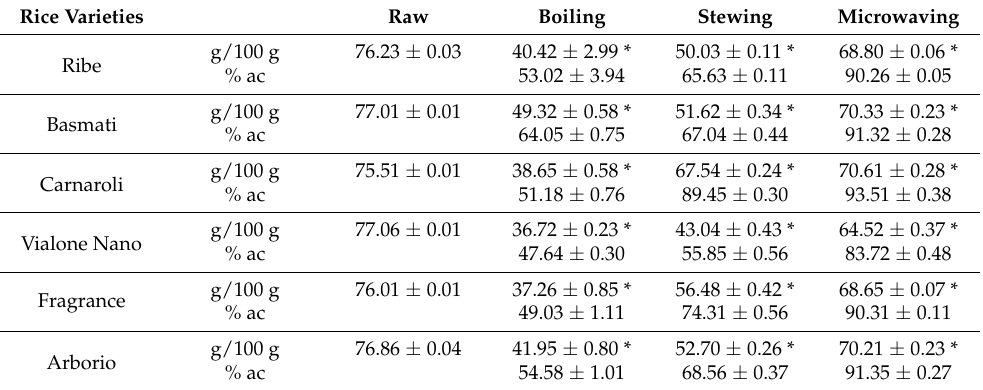
Table 4. Total carbohydrates content (g/100 g) of both raw and cooked rice and percentage of retained total carbohydrates after the three cooking methods